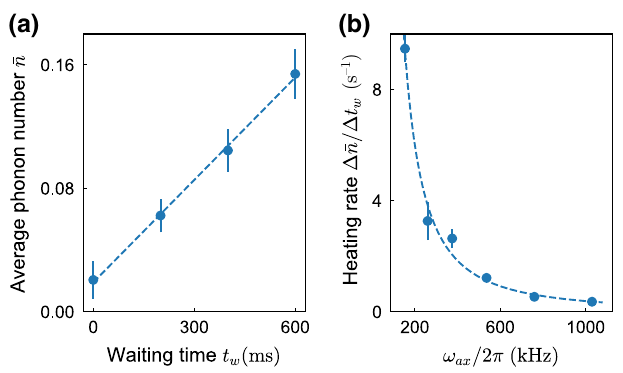
FIG. 15. Axial heating rates. (a) We calculate the heating rate of (cid:3) ¯ n /(cid:3) t w = 0.221 ± 0.007 s − 1 at ω ax = 1.05 MHz by fitting the increase in ¯ n over the waiting time t w , where ¯ n is determined from sideband thermometry. (b) Heating rates are determined as in (a) as a function of the trap frequency. The dashed line is a , where α ≈ power-law fit 1 /ω α ax